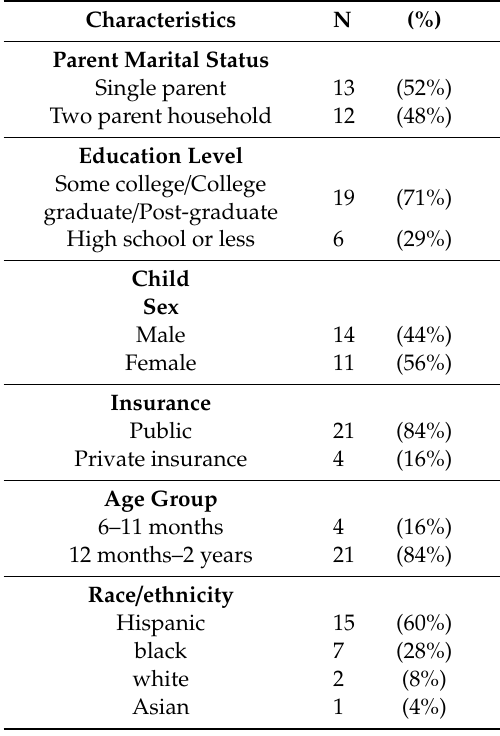
Table 2. Participant